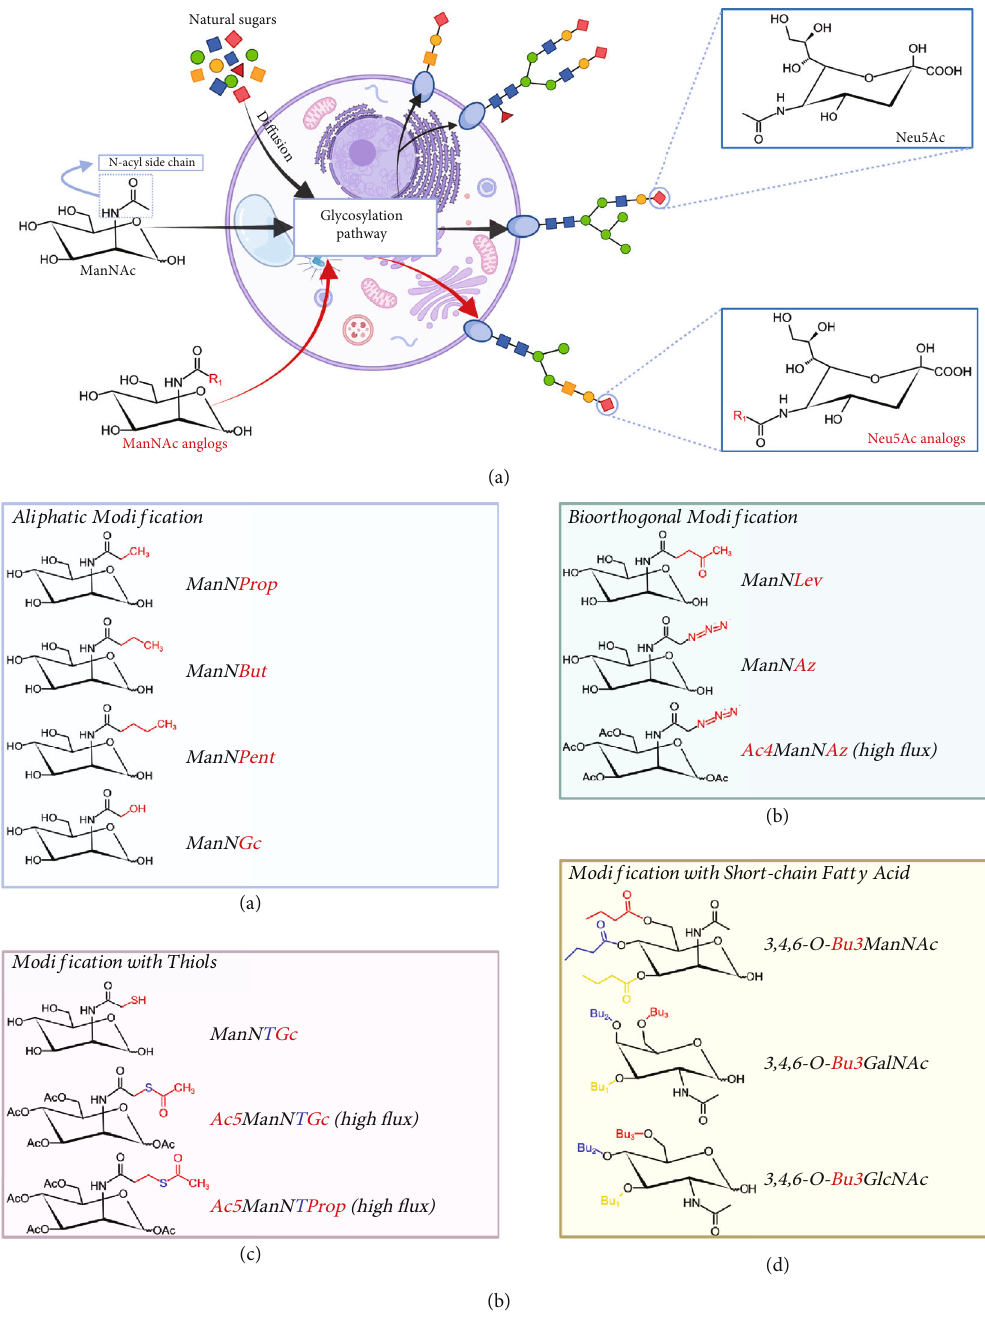
Figure 2: Overview of metabolic glycoengineering. (a) Illustration of MGE. Natural sugars are absorbed into cells and then metabolically assembled onto the cell surface as glycoconjugates (e.g., ManNAc into Neu5Ac). The analogs of metabolic precursors (ManNAc) can intercept the glycosylation pathways in cells, resulting in the submission of R-group-modi fi ed glycans and the modi fi cation of membranes. (b) Examples of MGE analogs. The analogs of MGE can be mainly classi fi ed into four catalogs: modi fi cation with aliphatic group, bioorthogonal group, thiol group, and short-chain fatty acid. The red marked text represents the R-group of di ff erent MGE analogs while the “ high fl ux ” indicates peracylated analogs with higher e ffi ciency of modi fi